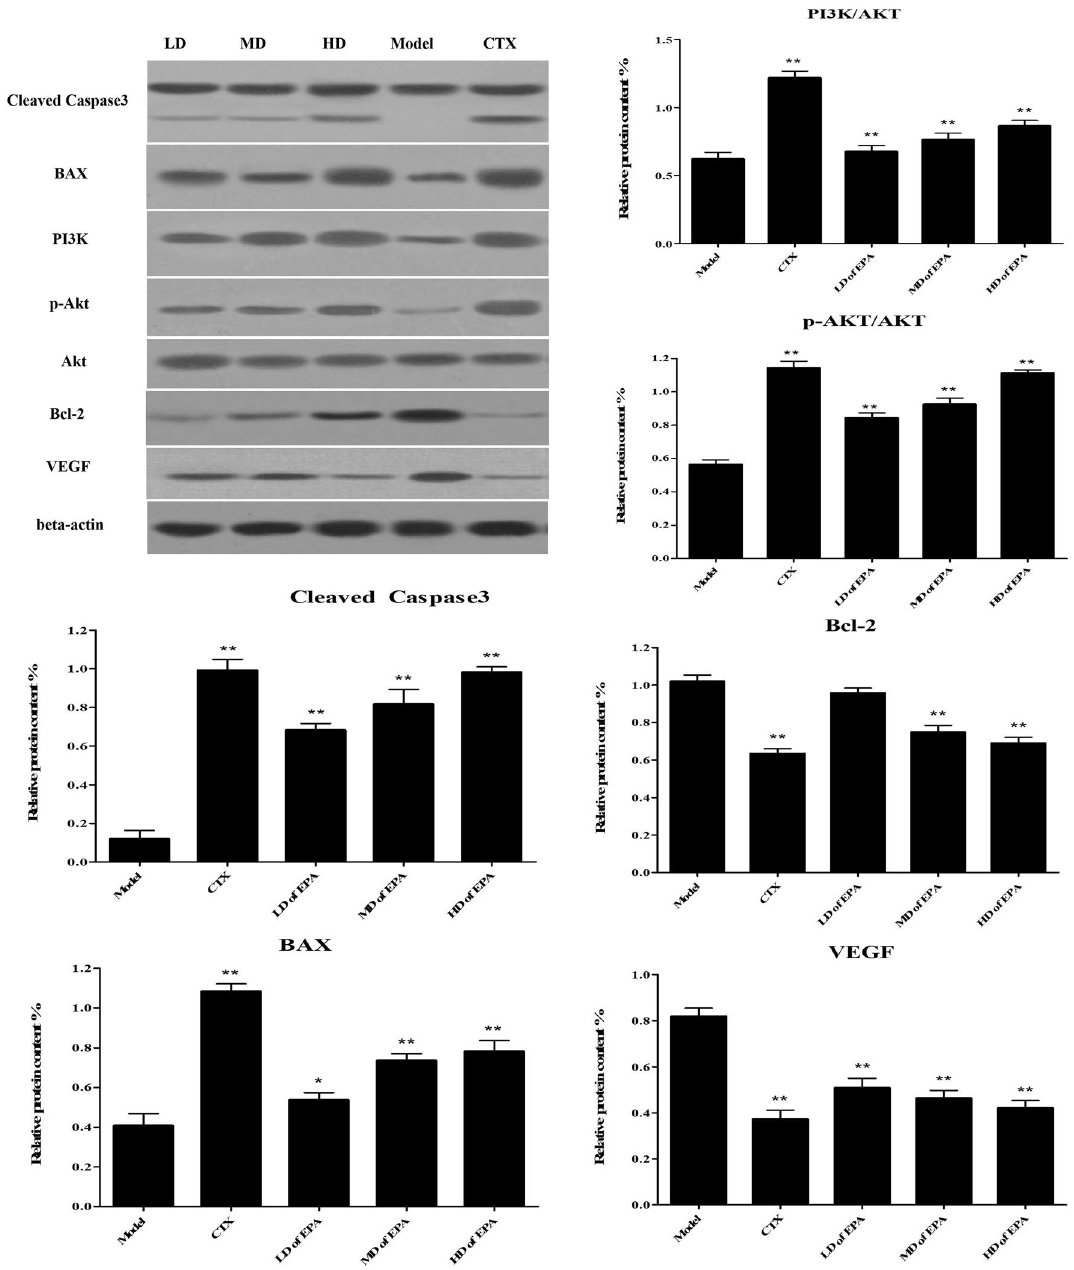
Figure 6. Relative protein expression of BAX, Bcl-2, Caspase3, AKT, p-AKT,PI3K and VEGF in tumor